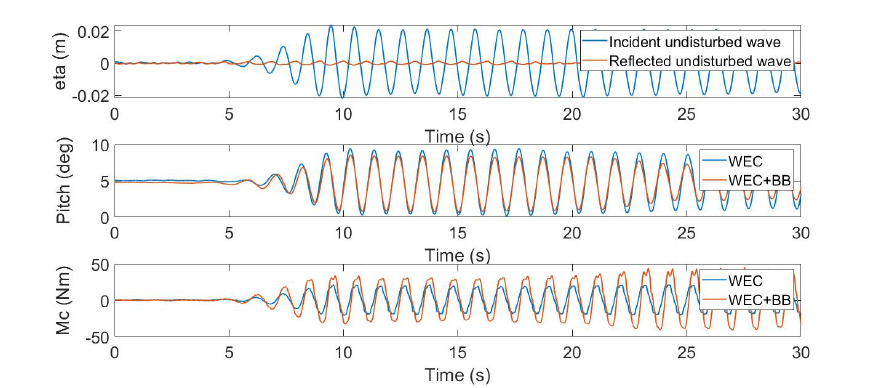
Figure 12. Wave basin experiments for a regular wave of period T = 1 s and height H 0 = 0.04 m (R09). eta is wave elevation calculated from undisturbed waves experiments; Pitch , the angle measured from free motion experiments, where the rest position was at 5 degrees approx.; and Mc is the control moment measured during wave excitation